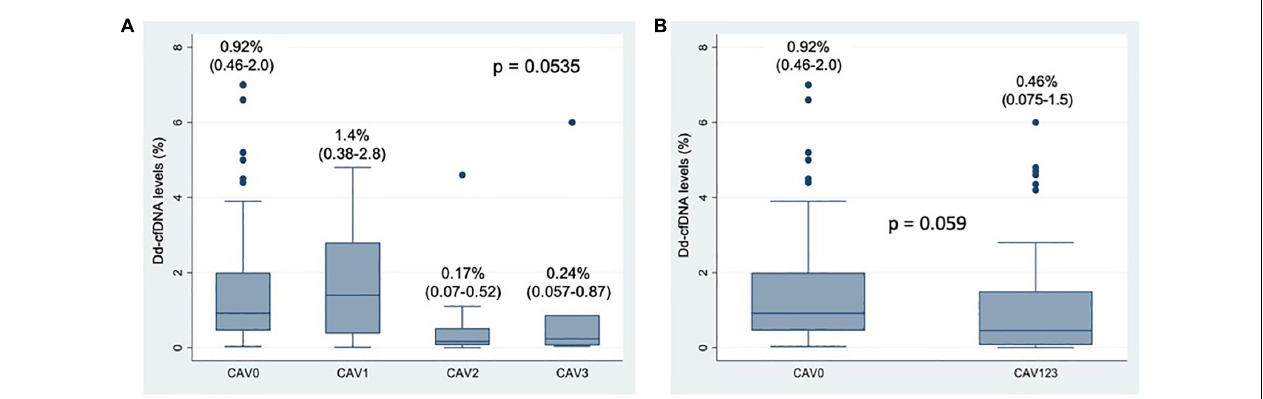
FIGURE 2 | (A) Box-plot of Donor-derived Cell Free DNA levels according to CAV degree. Numerical data represent median dd-cfDNA values and their interquartile range. (B) Box-plot of Donor-derived Cell Free DNA levels according to CAV presence (CAV0 vs. CAV 1, 2, or 3). Numerical data represent median dd-cfDNA values and their interquartile